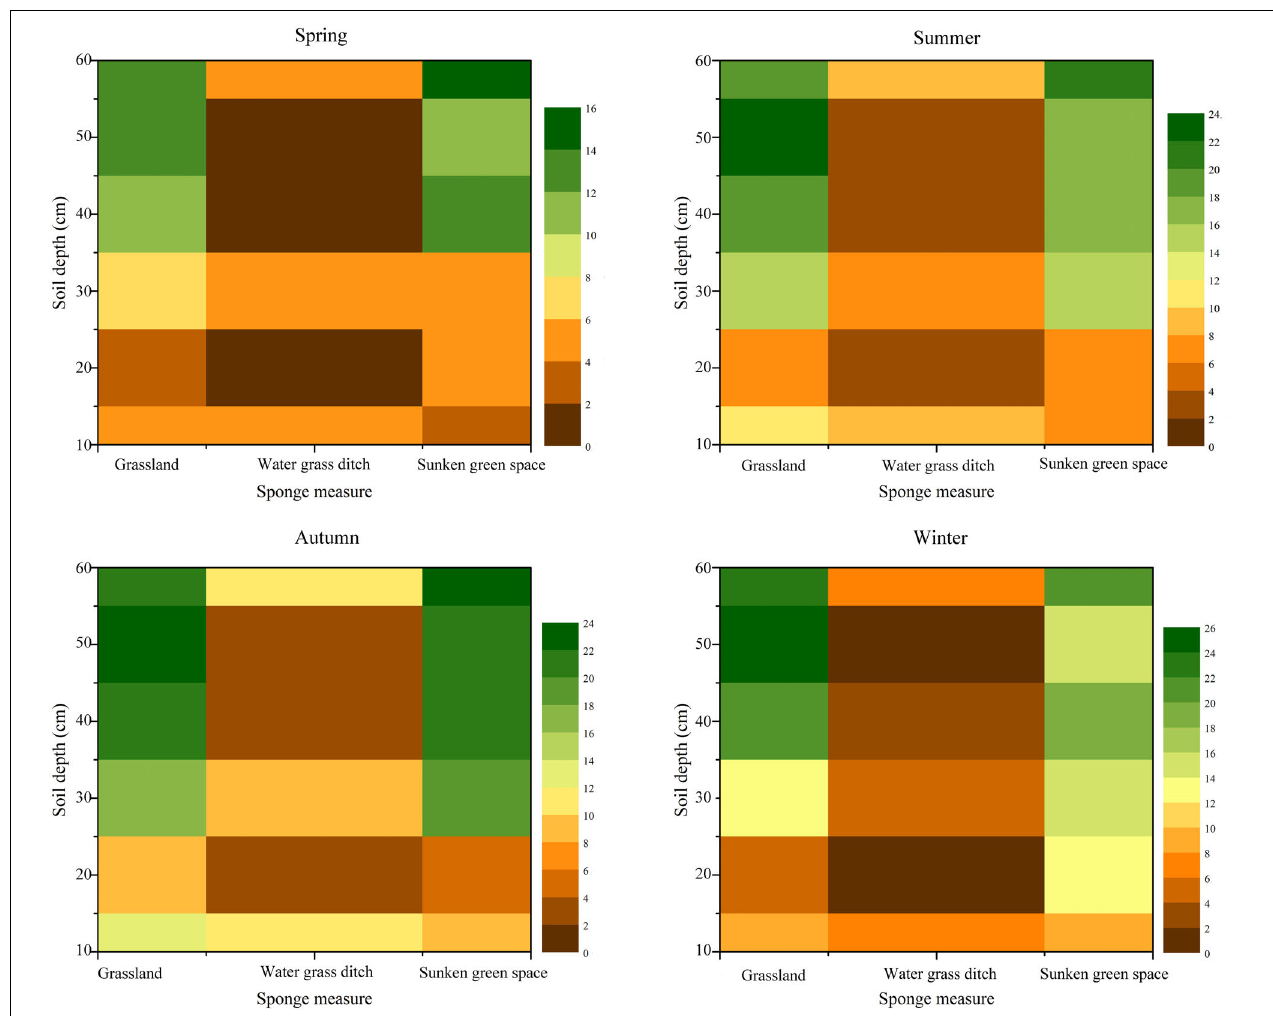
FIGURE 10 | Seasonal differences in soil moisture under different soil depths under different sponge